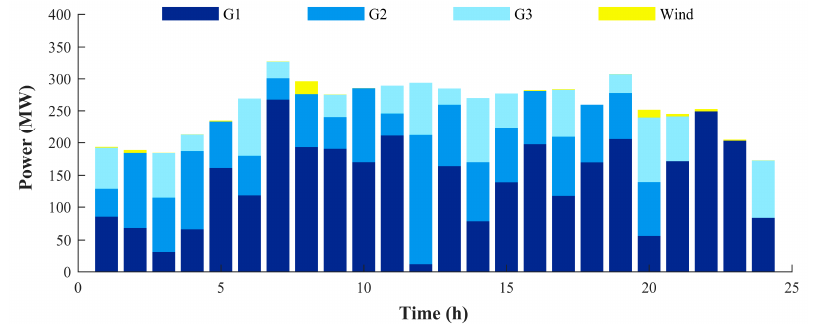
Figure 8. Dispatch result in Case 1.